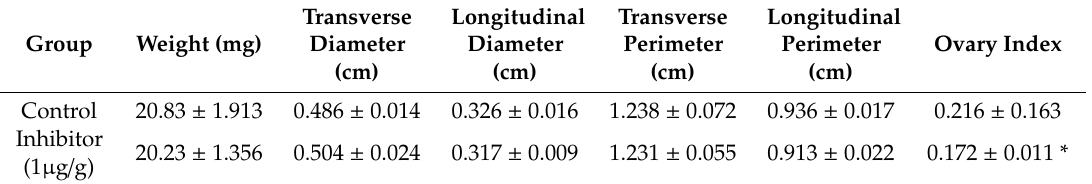
Table 2. Ovarian weight and size at vaginal opening (VO) after GABA-T inhibitor injection. Longitudinal Transverse Longitudinal Transverse Perimeter Ovary Index Perimeter Diameter Group Weight (mg) Diameter (cm) (cm) (cm) (cm) Control 20.83 ± 1.913 0.486 ± 0.014 0.326 ± 0.016 1.238 ± 0.072 0.936 ± 0.017 0.216 ± 0.163 Inhibitor 20.23 ± 1.356 0.504 ± (1 µ g / g)